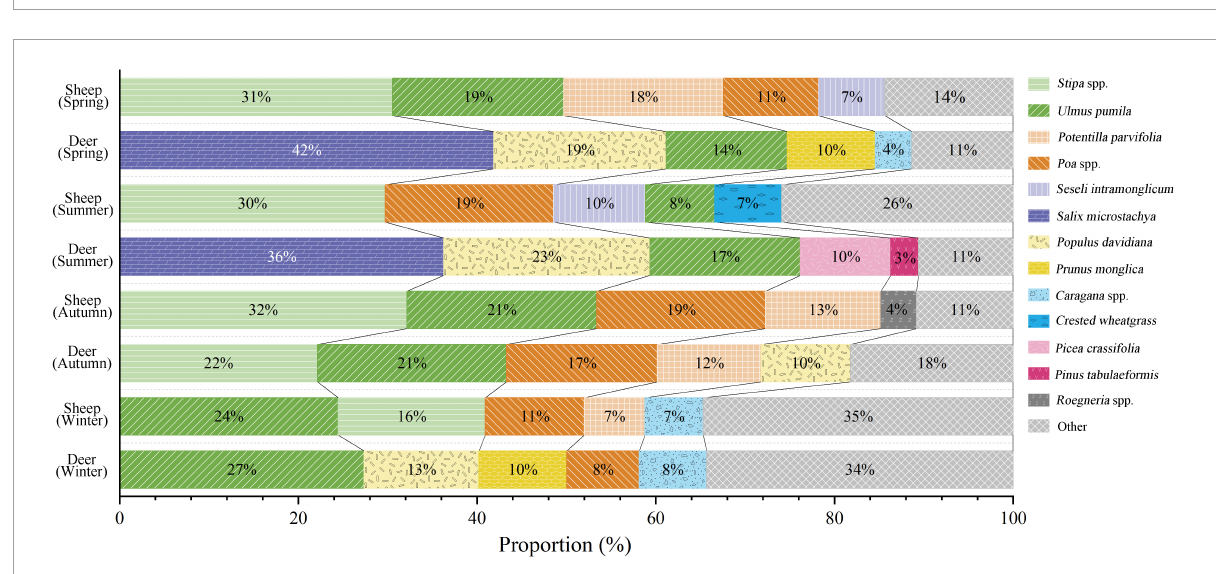
FIGURE6 The species of food overlap of blue sheep and red deer in different seasons (Luo, 2011). Different colored and filled color blocks represent different plant species eaten by blue sheep and red deer. The black line between the color blocks distinguishes the first food/second food/eaten by